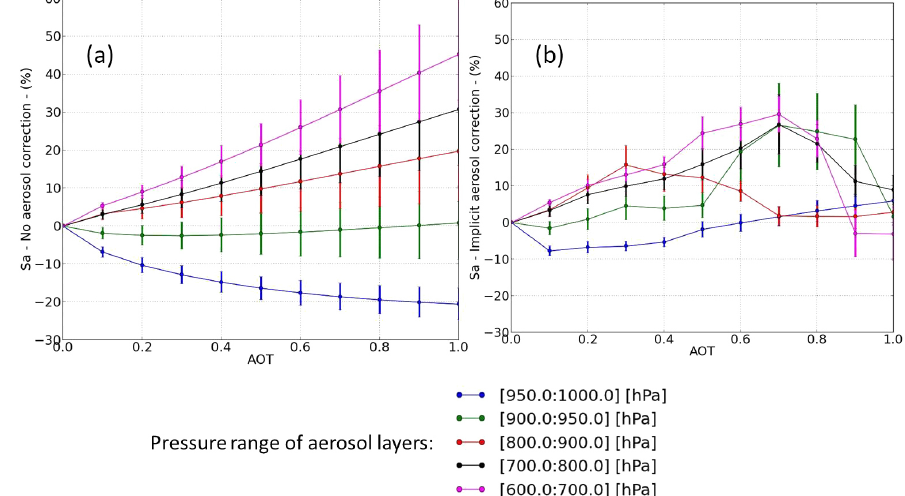
Figure 15. Comparison of relative tropospheric NO 2 AMF biases S A at 439nm (see Eq. 8) assuming different aerosol layers, surface albedo = 0.05, SZA = 25 ◦ , VZA = 25 ◦ , and TM5 NO 2 vertical profiles for the month of July at 12:00p . m . over China (see Fig. 1). Aerosol properties are defined by Ångström coefficient = 1.5, SSA = 0.95, and asymmetry parameter = 0.7. Solid lines are the average, while error bars are the standard deviation, of S A computed for all the individual TM5 NO 2 profiles over this period and this region: (a) S A assuming no aerosol correction, (b) S A assuming implicit aerosol correction through the OMI cloud retrieval algorithm.